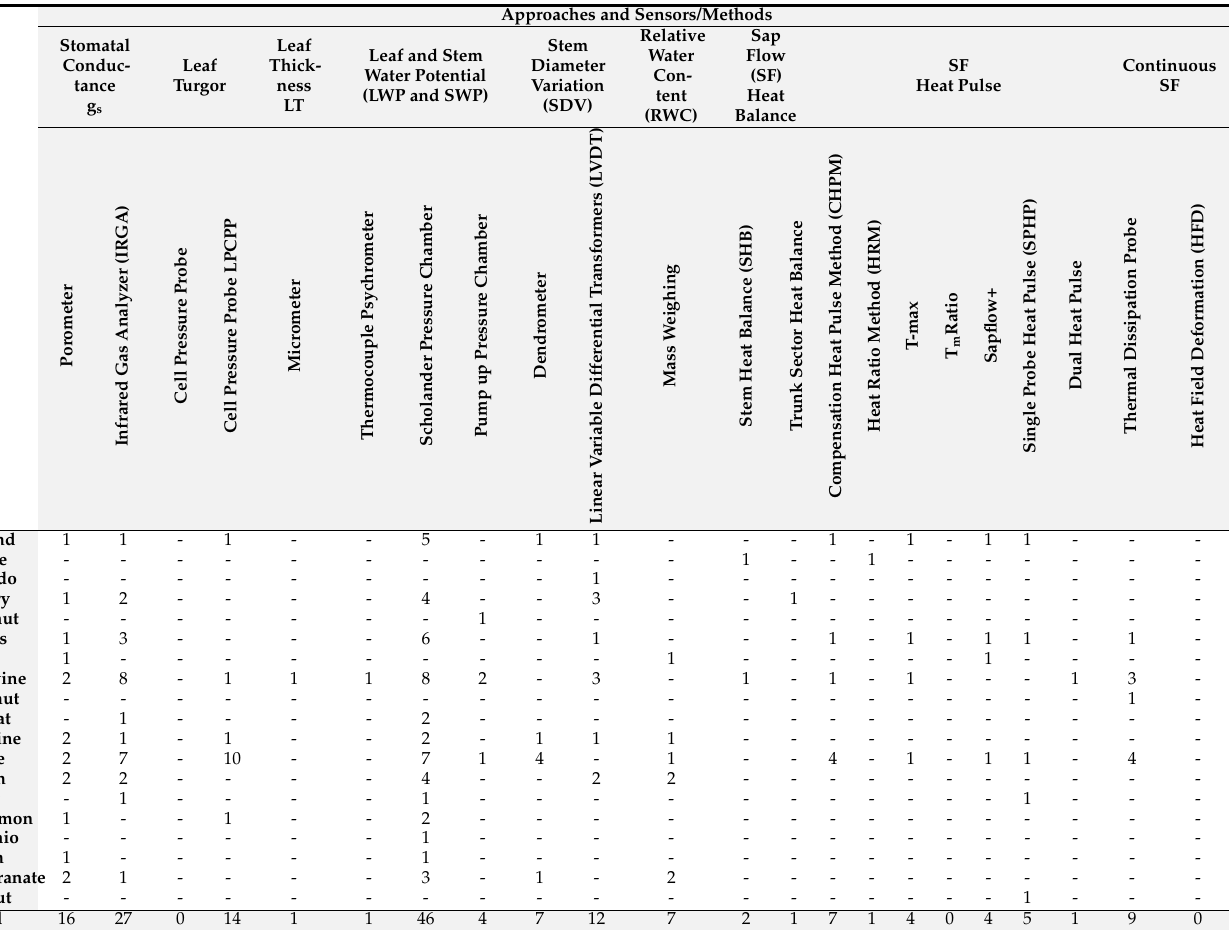
Table 3. Approaches and sensors/methods to assess plant water status from 2012 to 2022 per Mediterranean fruit and nut tree